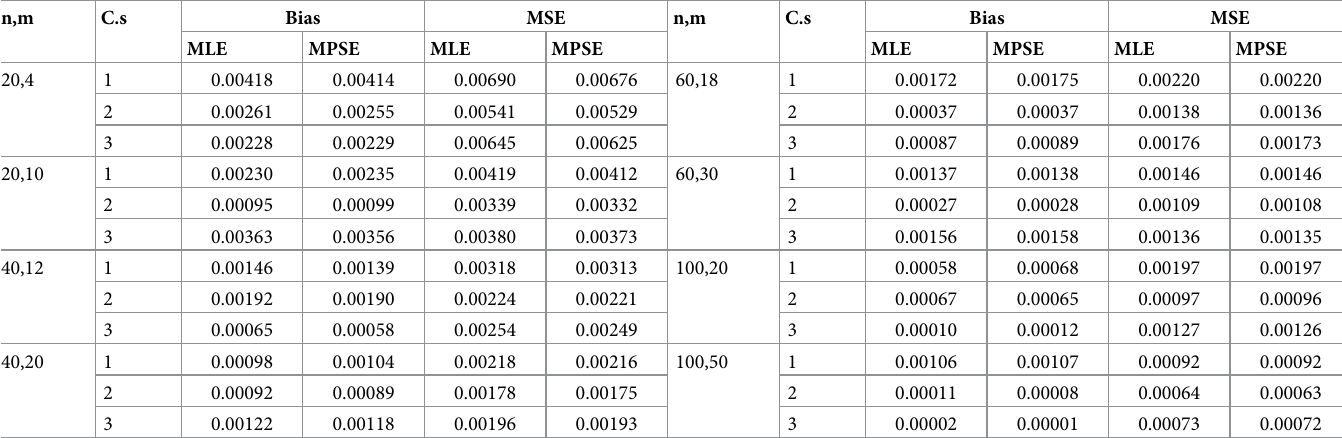
Table 4. Bias and MSE of θ with T